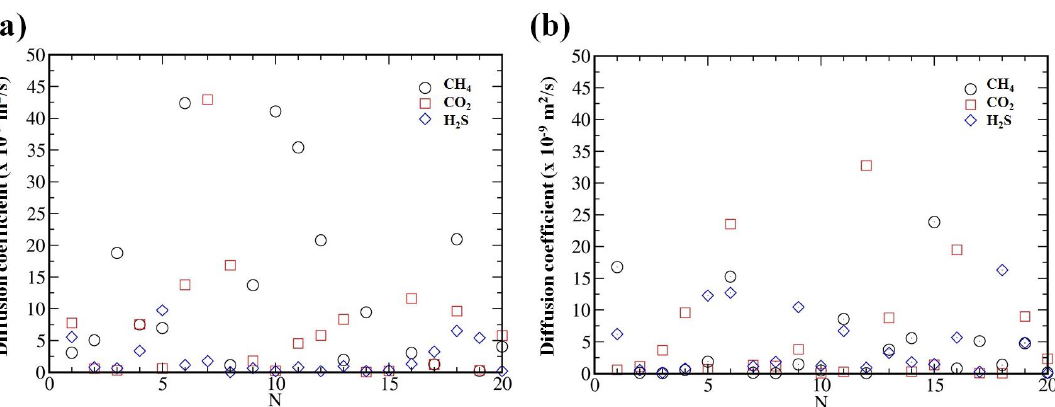
Figure 3. Diffusion coefficients of CH 4 , CO 2 and H 2 S in choline-benzoate ( a ) and choline-lactate ( b ) samples obtained in 20 various simulations.